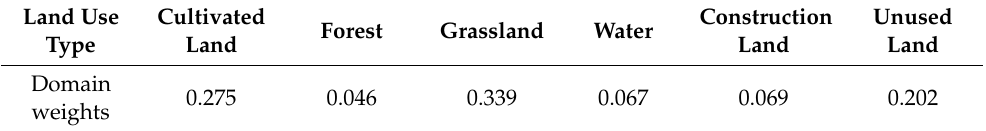
Table 1. Setting of Contextual Factor